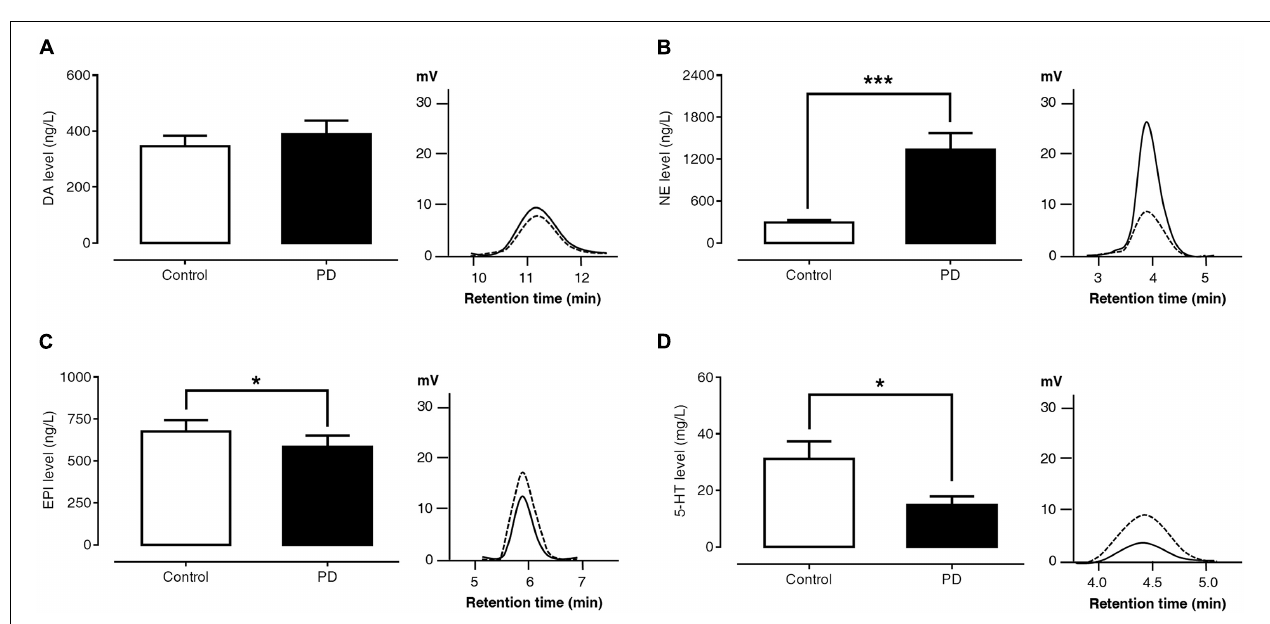
FIGURE 1 | Comparisons of plasma DA (A) , NE (B) , EPI (C) , and 5-HT (D) levels and HPLC chromatograms between control subjects (dash lines) and PD patients (solid lines). Data are presented as mean ± SEM (* p < 0.05, *** p < 0.001).